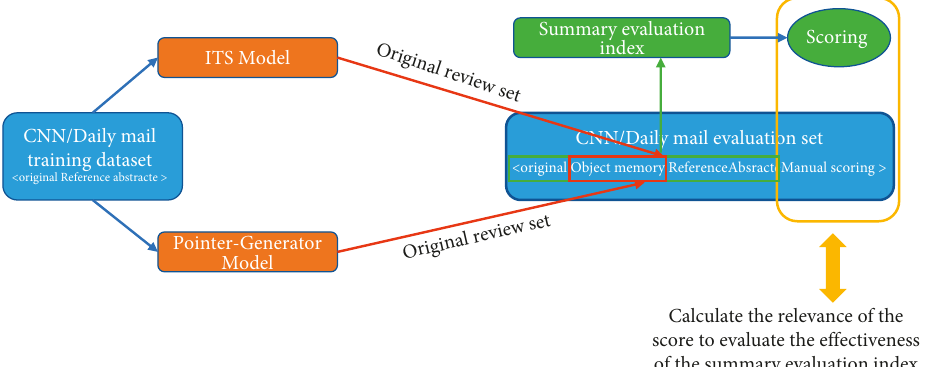
Figure 7: Calculate the relevance of the score to evaluate the effectiveness of the summary evaluation